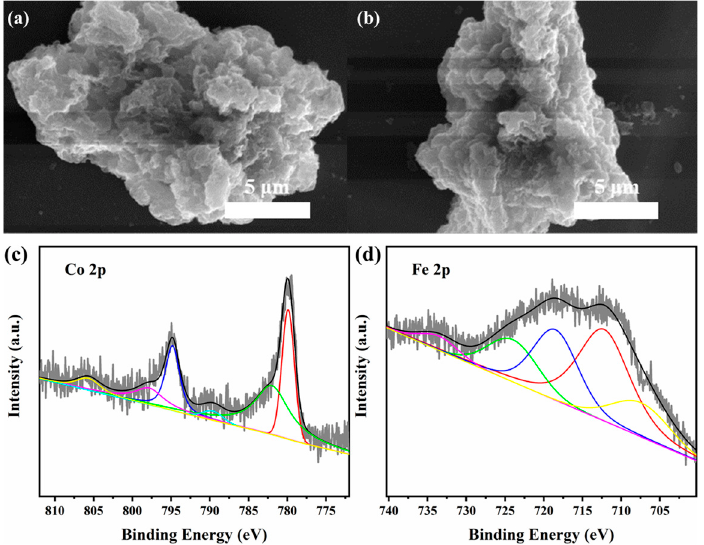
Figure 5. ( a , b ) SEM images of Co(OH) 2 @TA ‐ Fe that had undergone stability test and XPS spectra of Co(OH) 2 @TA ‐ Fe after stability test: ( c ) Co 2p region, ( d ) Fe 2p region.